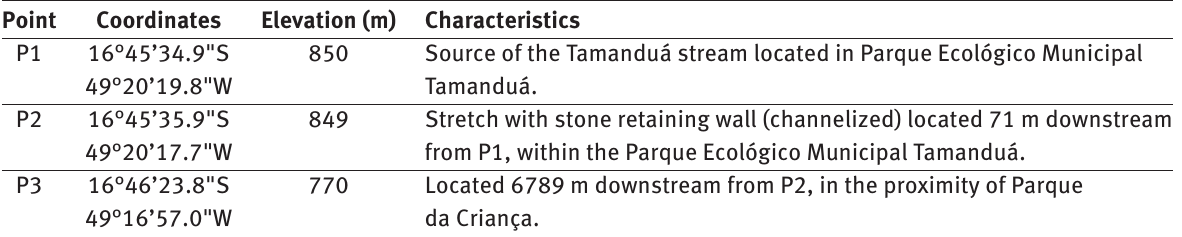
Table 1: Coordinates and description of the sampling points along the Tamanduá stream.